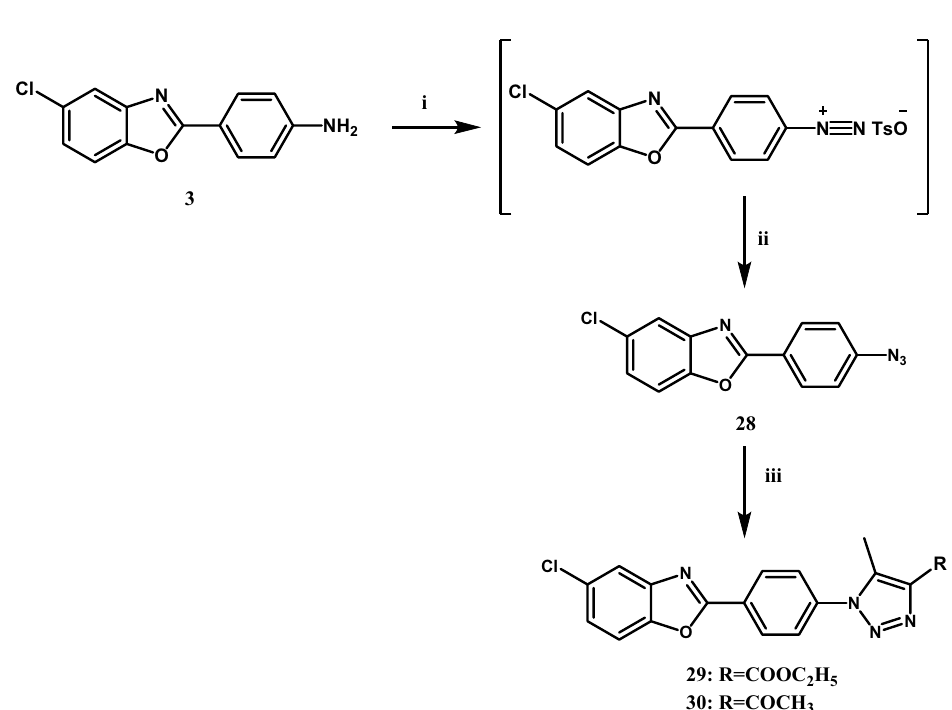
Figure 5. Synthetic scheme of target benzoxazole derivatives 26, 27 .